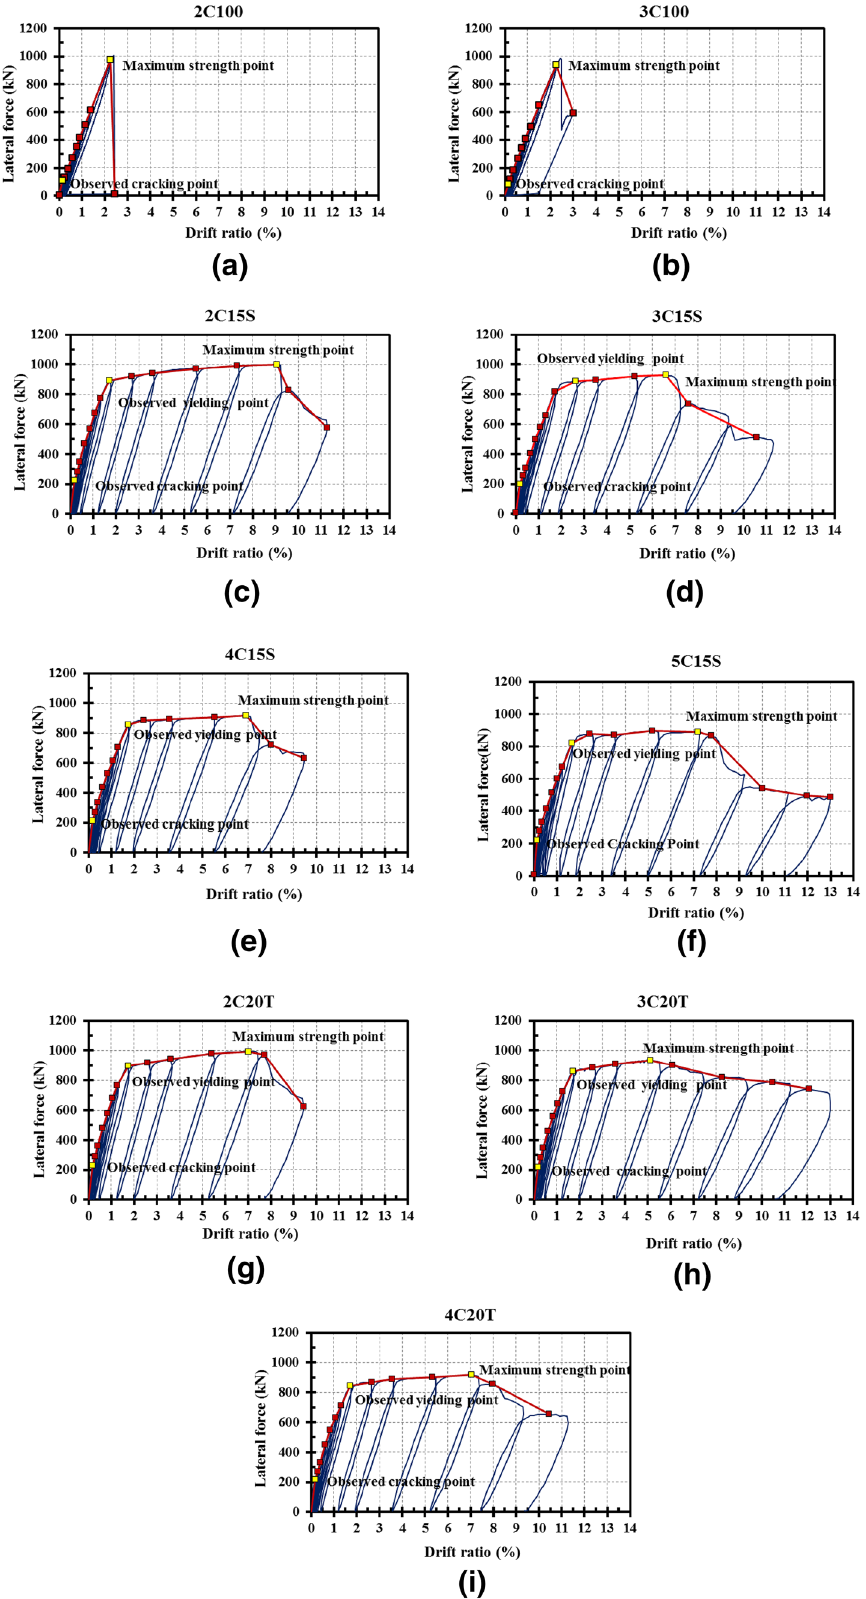
Fig. 10 Relationship between the lateral force and drift ratio of member for each specimen. a 2C100, b 3C100, c 2C15S, d 3C15S, e 4C15S, f 5C15S, g 2C20T, h 3C20T, and i